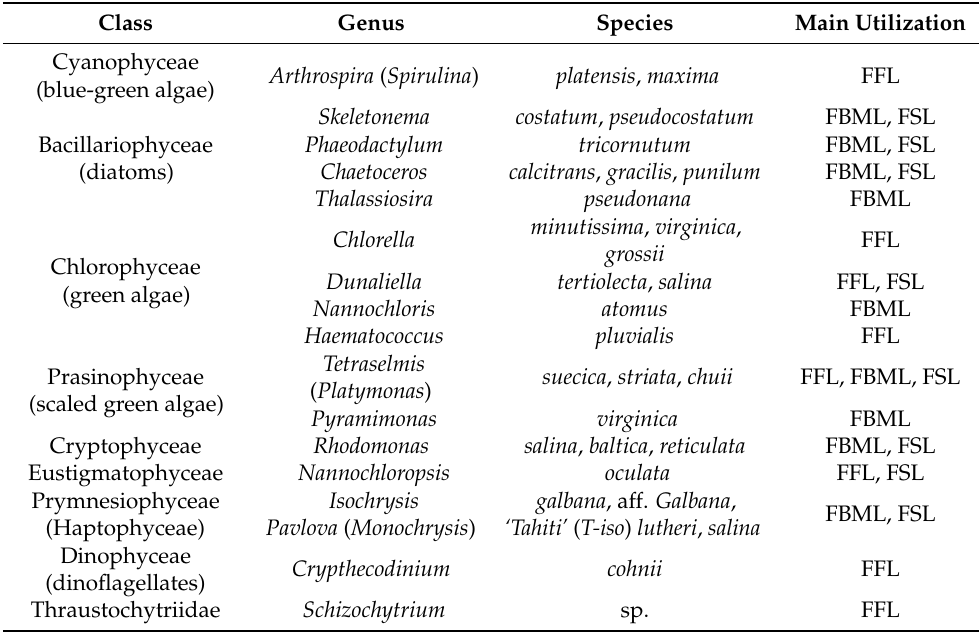
Table 1. Classes, genera, and species of major currently named microalgae grown for food in aquaculture and their main utilization. FFL: food for fish larvae; FBML: food for bivalve mollusc larvae; FSL: food for shrimp larvae. Source: modified and updated from Silva et al. [25] and Muller-Feuga [26].